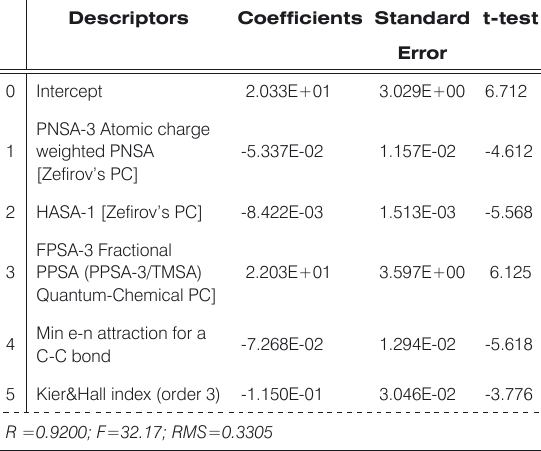
Table 2. Descriptors, Coefficients, Standard Error, and t-Test Values for the MLR.